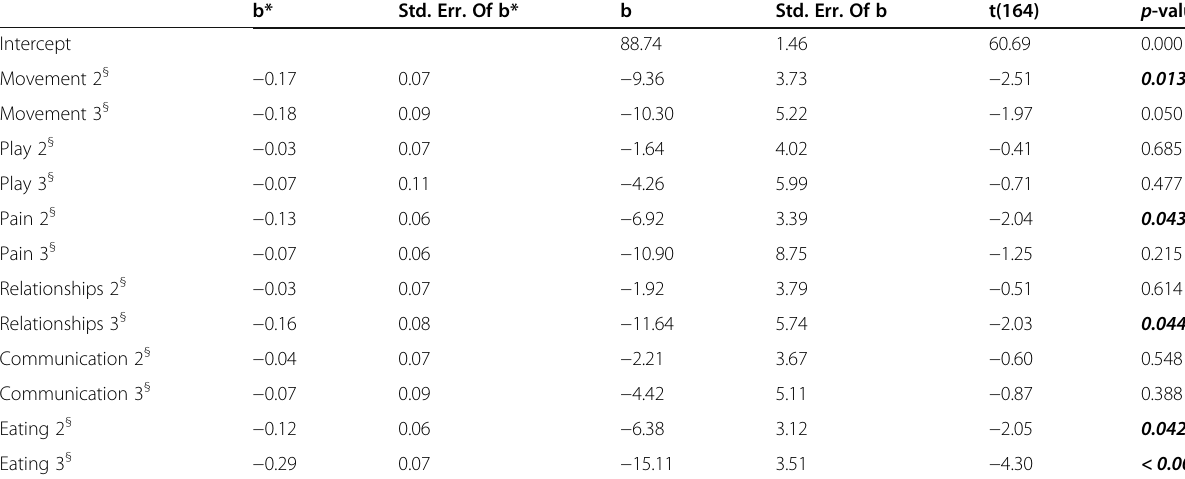
Table 6 Regression Analysis of the TANDI VAS Score and Dimension Scores b* Std. Err. Of b* b Std. Err. Of b